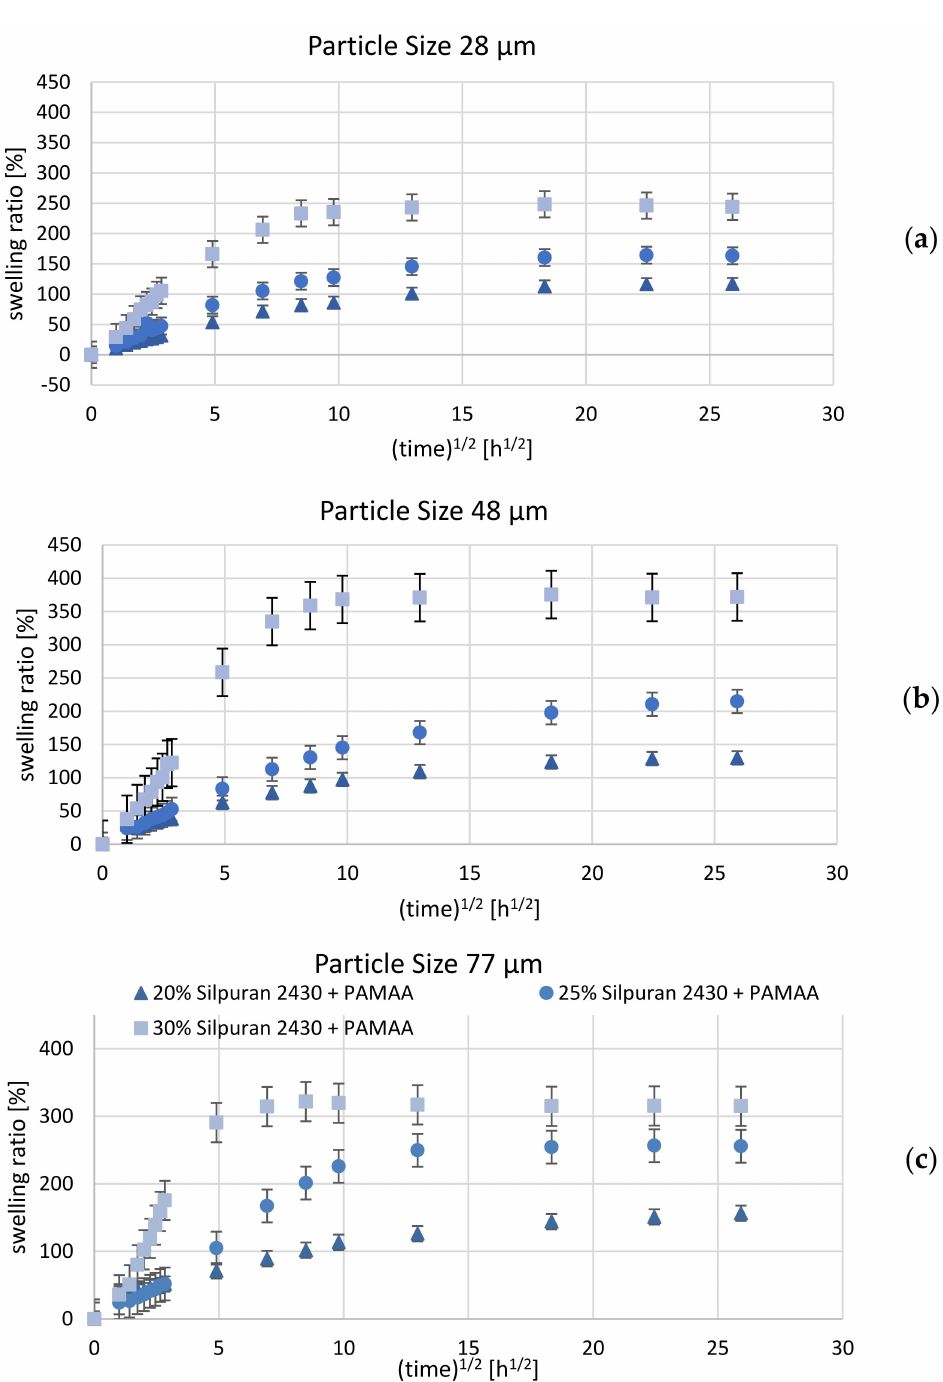
Figure 5. Mean swelling ratio over square root of time (total swelling time: 672 h) for Silpuran 2430-PAMAA composite samples with initial hydrogel content of 20 wt%, 25 wt%, and 30 wt%. Error bars indicate standard deviation for test samples with hydrogel particle size (median) of ( a ) 28 µ m, ( b ) 48 µ m, and ( c ) 77 µ m. For each material combination, n = 6 samples were